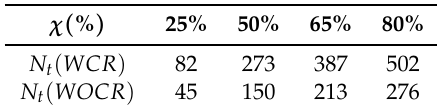
Table 1. Maximum number of allowable transmitter (TX) antennas in a given overhead of reference signal (RS), χ ( % ) .